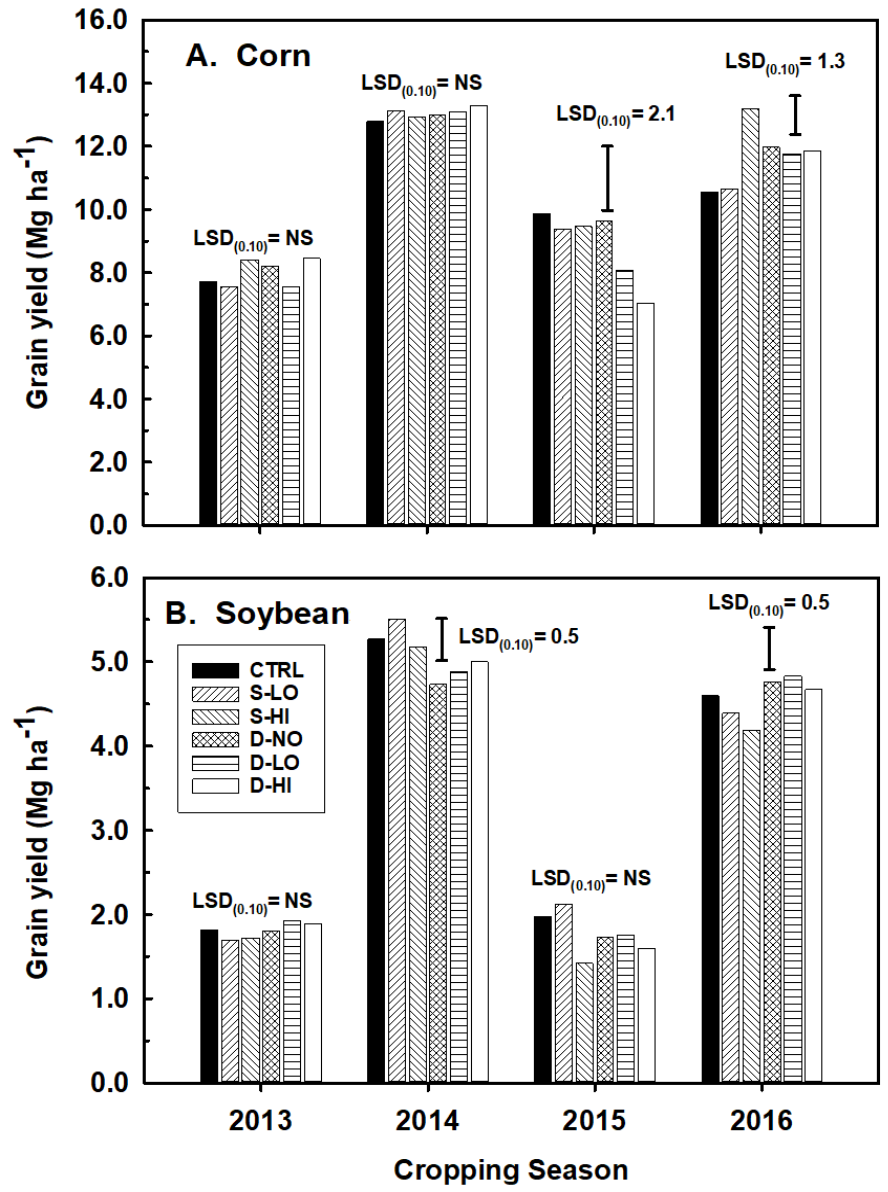
Figure 4. ( A , B ) Trial #2 grain yields (Mg ha −1 ) for ( A ) corn and ( B ) soybean due to lime treatments from the 2012 to 2016 cropping seasons. LSD (0.10) is least significant differences at p ≤ 0.10. (Abbreviations: CTRL, control; S-LO, surface 3.4 Mg ha −1 ; S-HI, surface 6.7 Mg ha −1 ; D-NO, deep tillage no lime; D-LO, deep placement 3.4 Mg ha −1 ; D-HI, deep placement 6.7 Mg ha −1 ; NS, not significant).